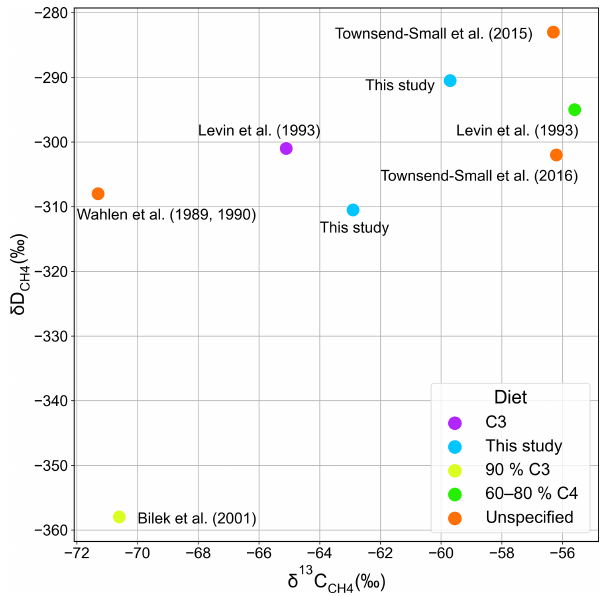
Figure 5. A dual isotope plot comparing the δ 13 C CH for cattle from this study with the values reported in the literature (indicated next to the data